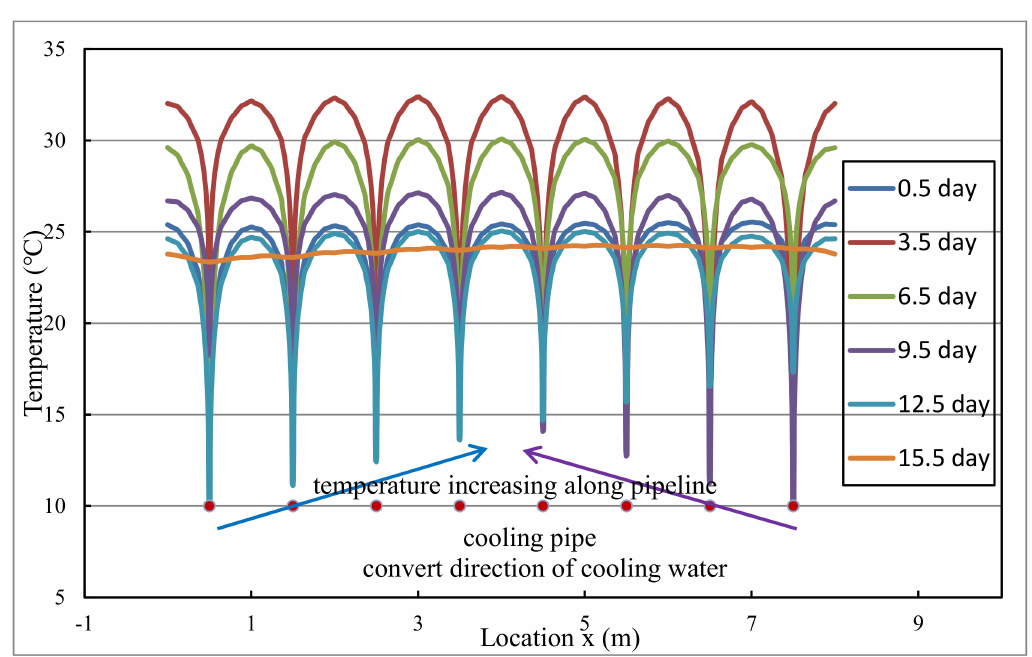
Figure 6. The evolution of temperature distribution along representative line in layer 2#.